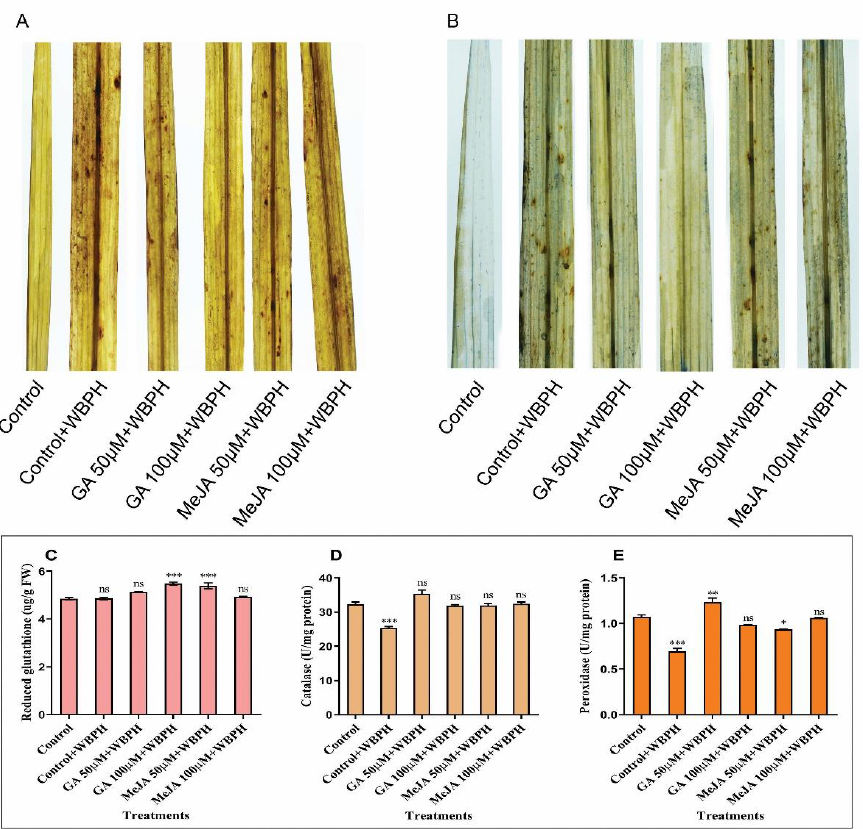
Figure 3. Effects of GA and MeJA applications on white-backed planthopper (WBPH) stress through the induction of hypersensitive responses and antioxidant activities. ( A ) DAB staining for H 2 O 2 accumulation. ( B ) Trypan blue staining for detection of dead cells. ( C ) GSH, ( D ) CAT, and ( E ) POD accumulation in response to GA and MeJA applications toward WBPH infestation. Each result is the mean of three replicates. Error bars represent the standard error of the mean data ( n = 3), ns represents not significant, and asterisks denote a significant difference (* p < 0.05, ** p < 0.01, *** p < 0.001), according to the analysis using two-way ANOVA and the Bonferroni post hoc test. The experiments were repeated three